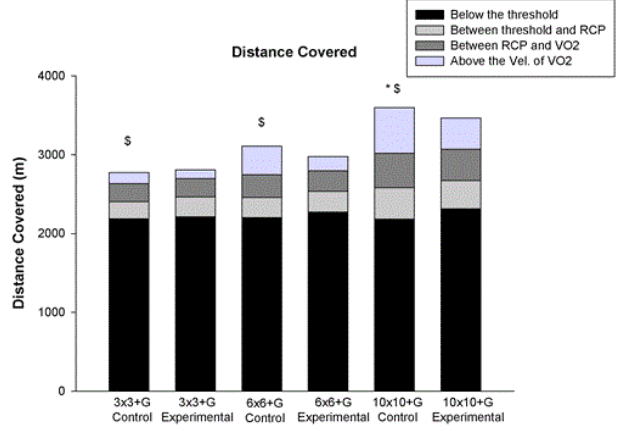
Figure 1. Comparison between the distances covered at different ve- locity ranges between the control and experimental fields.